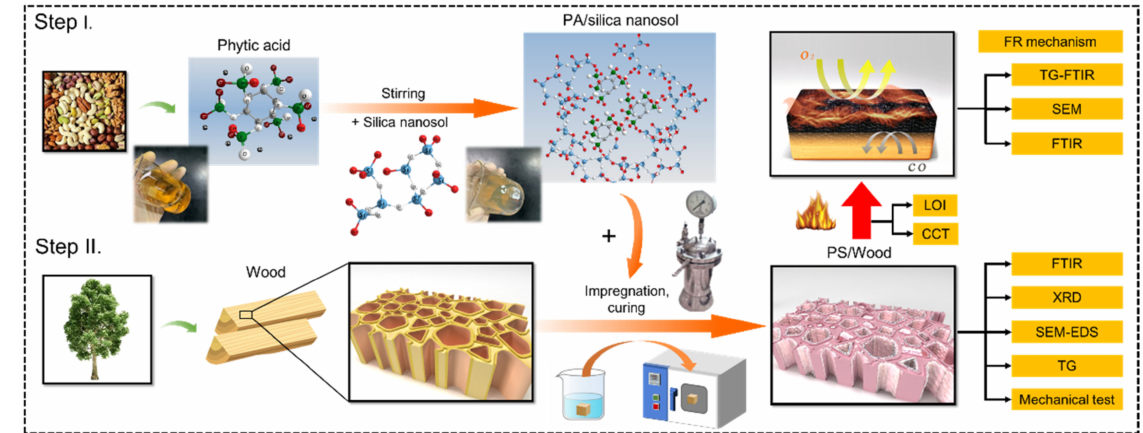
Figure 1. Schematic of an overview on experimental techniques applied in this